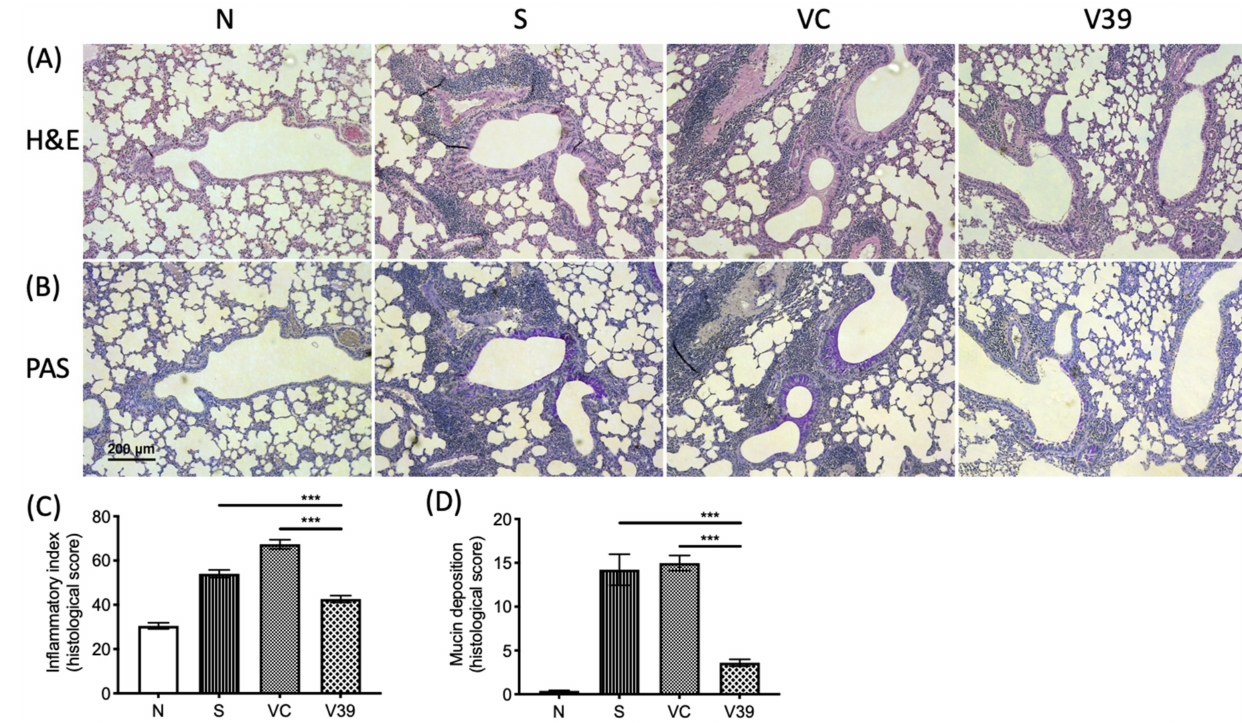
Figure 3. Inflammatory cell infiltration and mucin deposition was decreased by the treatment of rAAV-CD39. The Formaldehyde-fixed, paraffin-embedded lung samples were sliced and stained by ( A ) hematoxylin and eosin (H&E) and ( B ) periodic acid-Schiff (PAS). The quantitative data of each slide was analyzed by ImageJ and presented as a histological score, including ( C ) inflammatory index and ( D ) mucine deposition (the purple-magenta color in B). There were 5 areas in 2 fields from 4–6 slides applied for quantification. Scale bar = 50 µ m. Data are presented as a median with an interquartile range (*** p < 0.001 in the comparison of V39 with S or